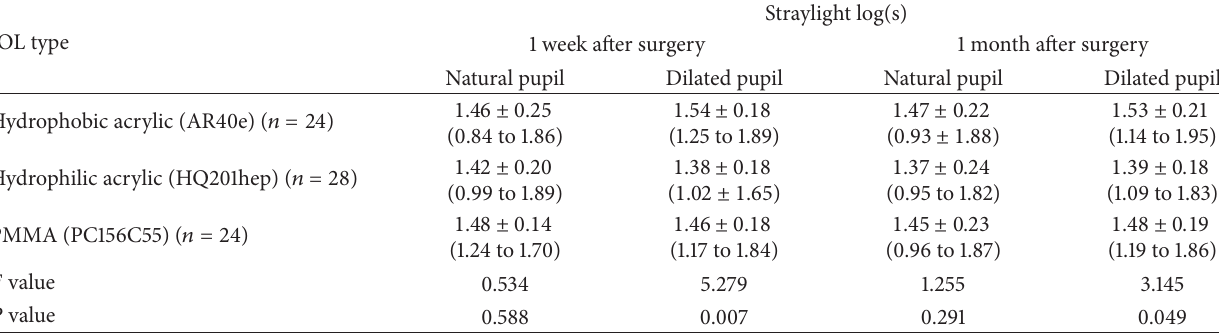
Table 3: Straylight values of pseudophakic eyes with hydrophobic acrylic, hydrophilic acrylic, and rigid PMMA IOLs. IOL